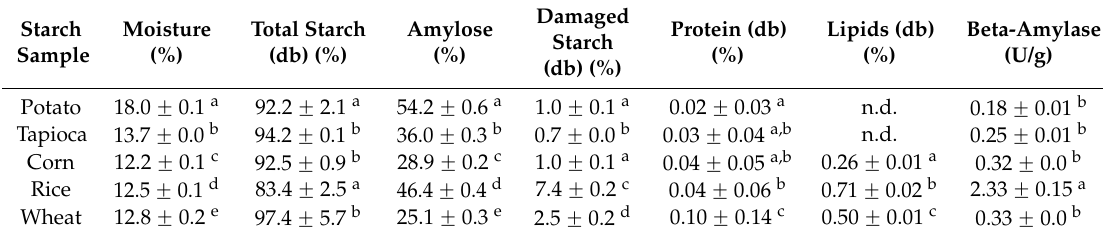
Table 1. Overview of the different starch compositions. Results are shown as the mean values ± confidence interval of 3 replicates.